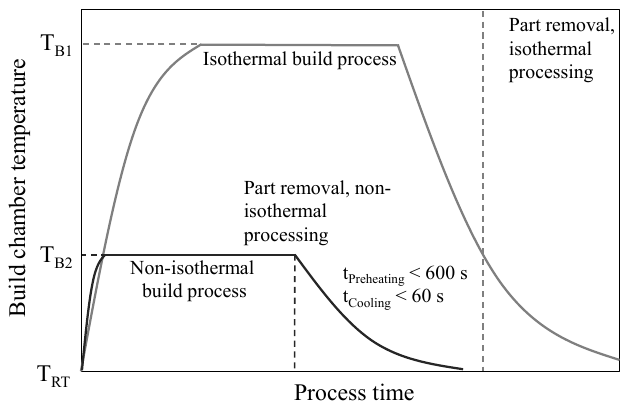
Figure 2. Schematic time-dependent temperature variation for applying quasi-isothermal and non- isothermal processing.